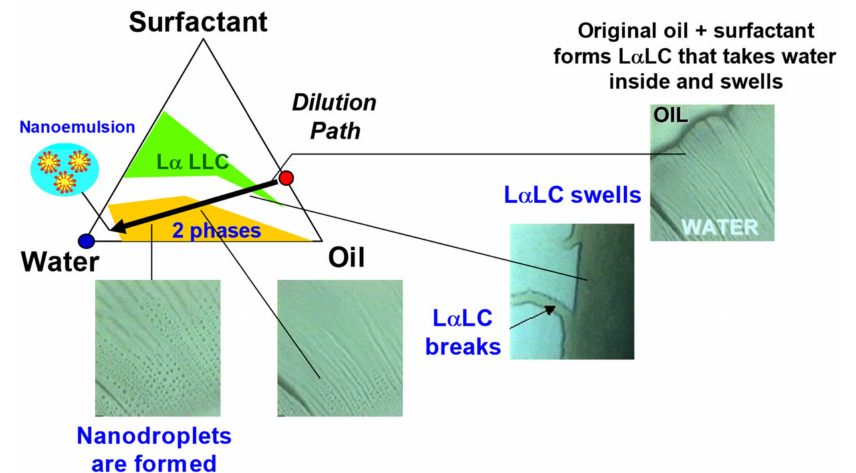
Figure 19. Spontaneous emulsification method is shown in a schematic surfactant-oil-water ternary diagram. The red dot on the surfactant-oil axis is the starting composition. The arrow shows the path followed during aqueous phase addition and the structures formed during this